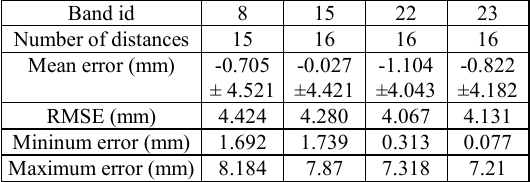
Table 6. Results obtained for check distances for each set of bands